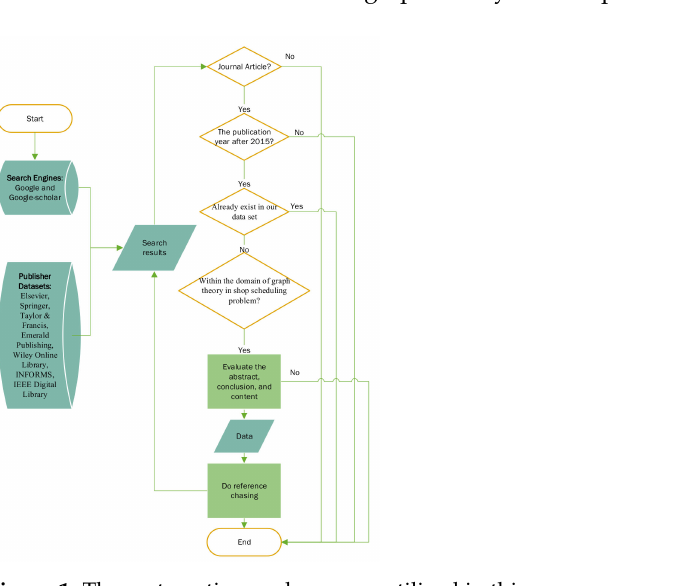
Figure 1. The systematic search process utilized in this